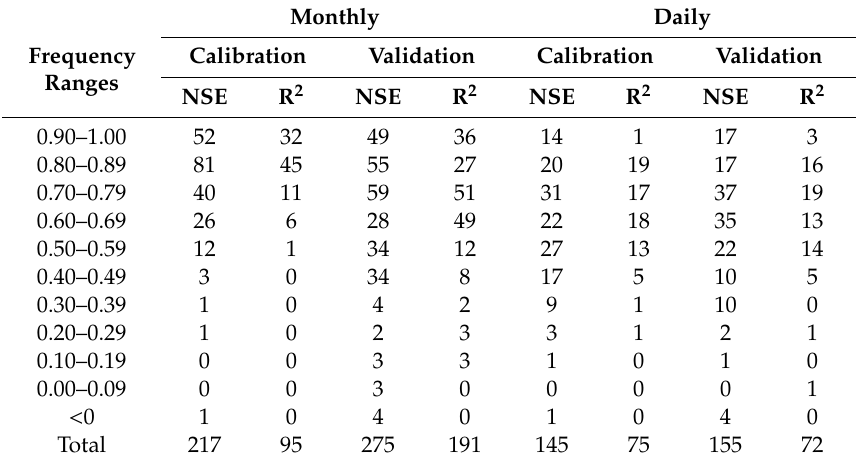
Table 2. Summary of reported SWAT model performance in streamflow simulations in Southeast